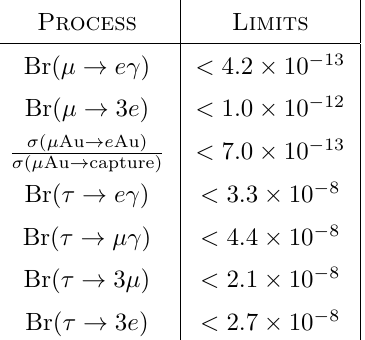
Table 5. Values given without citation are taken from ref.